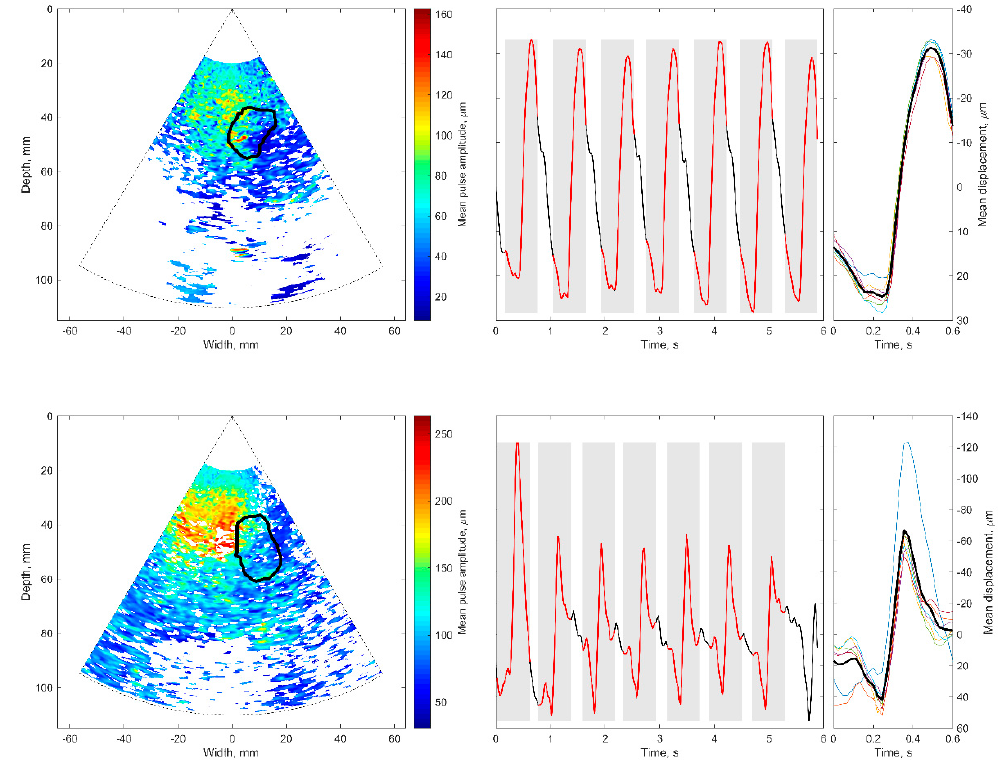
Figure 10. Confidence mapping of displacements in the coronal plane of the brain ( upper images for a patient with Alzheimer’s disease, lower images for healthy elderly participant): ( left ) locations of confident displacements with annotated hippocampus ROI; ( middle ) spatial averaged accumulated displacements in the ROI, similar segments are in grey rectangles with red lines; ( right ) superimposed similar segments (tiny colorful lines) and their average (bold black line).